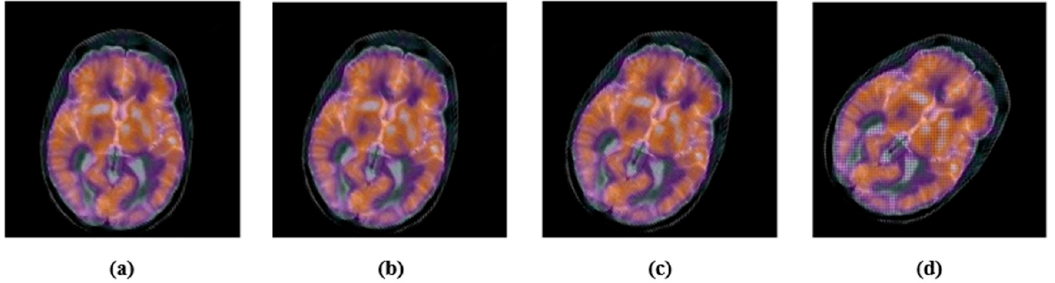
Table 3. Geometric attacks and their parameterization.